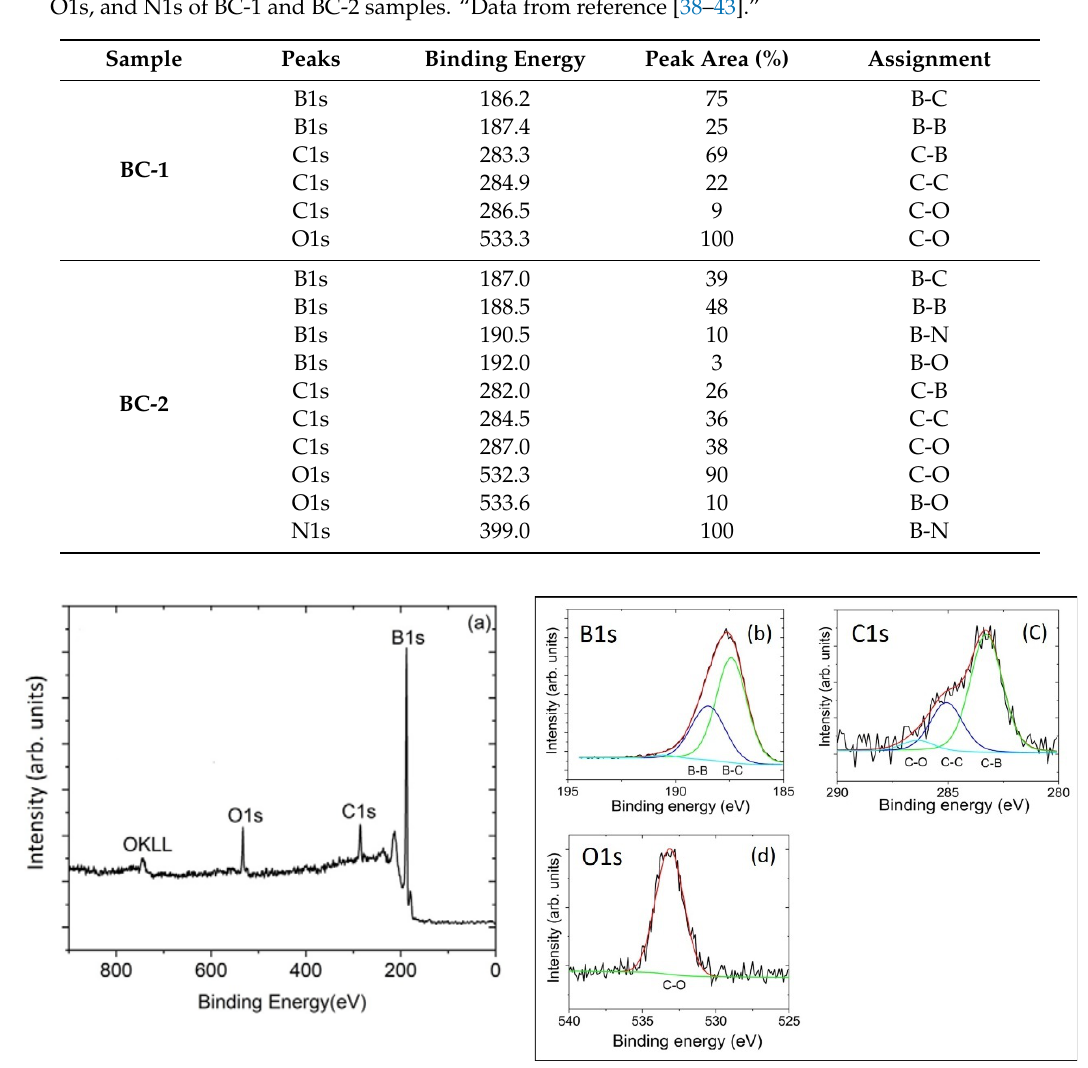
Figure 3. X-ray photoelectron spectroscopy survey scans of ( a ) the BC-2 coating with an elemental composition of 81.0% B, 12.6% C, 4.4% O, and 2.0% N. Panels ( b ), ( c ), ( d ), and ( e ) show high-resolution scans for B1s, C1s, O1s, and N1s, respectively, with corresponding peaks assigned to B-C, B-B, C-C (adventitious carbon), and C-O bonding. Sample BC-2 also shows bonding associated with B-N and B-O.